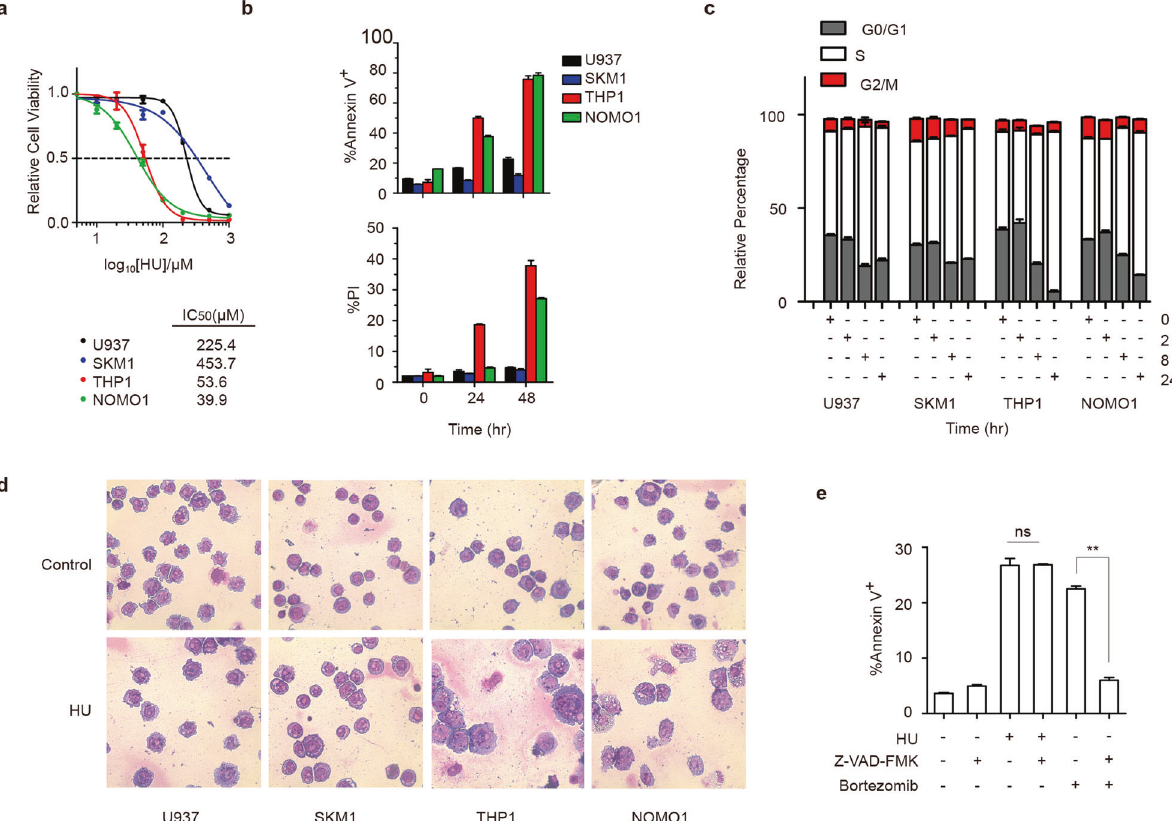
Fig. 1 MLL-AF9 AML cells are sensitive to HU treatment. a Cell viability of indicated AML cell lines with HU treatment after 72 h. The IC 50 of different cells was quanti fi ed. b Cells with 100 μ M HU treatment were stained using Annexin V and propidium iodide. c Cell cycle pro fi les were analyzed upon indicated hours of exposure to 100 μ M HU. d Cells were stained with Wright-Giemsa staining upon 24 h treatment with 100 μ M HU. Magni fi cation is 200×. e THP1 cells were pretreated with the apoptosis inhibitor 100 μ M Z-VAD-FMK for 1 h, then treated with 100 μ M HU or 10 nM bortezomib for 24 h, the viability was analyzed. ** P < 0.01; the ns indicate no signi fi cant difference; two-tailed t- test. Data represent the means of triplicate reactions ±